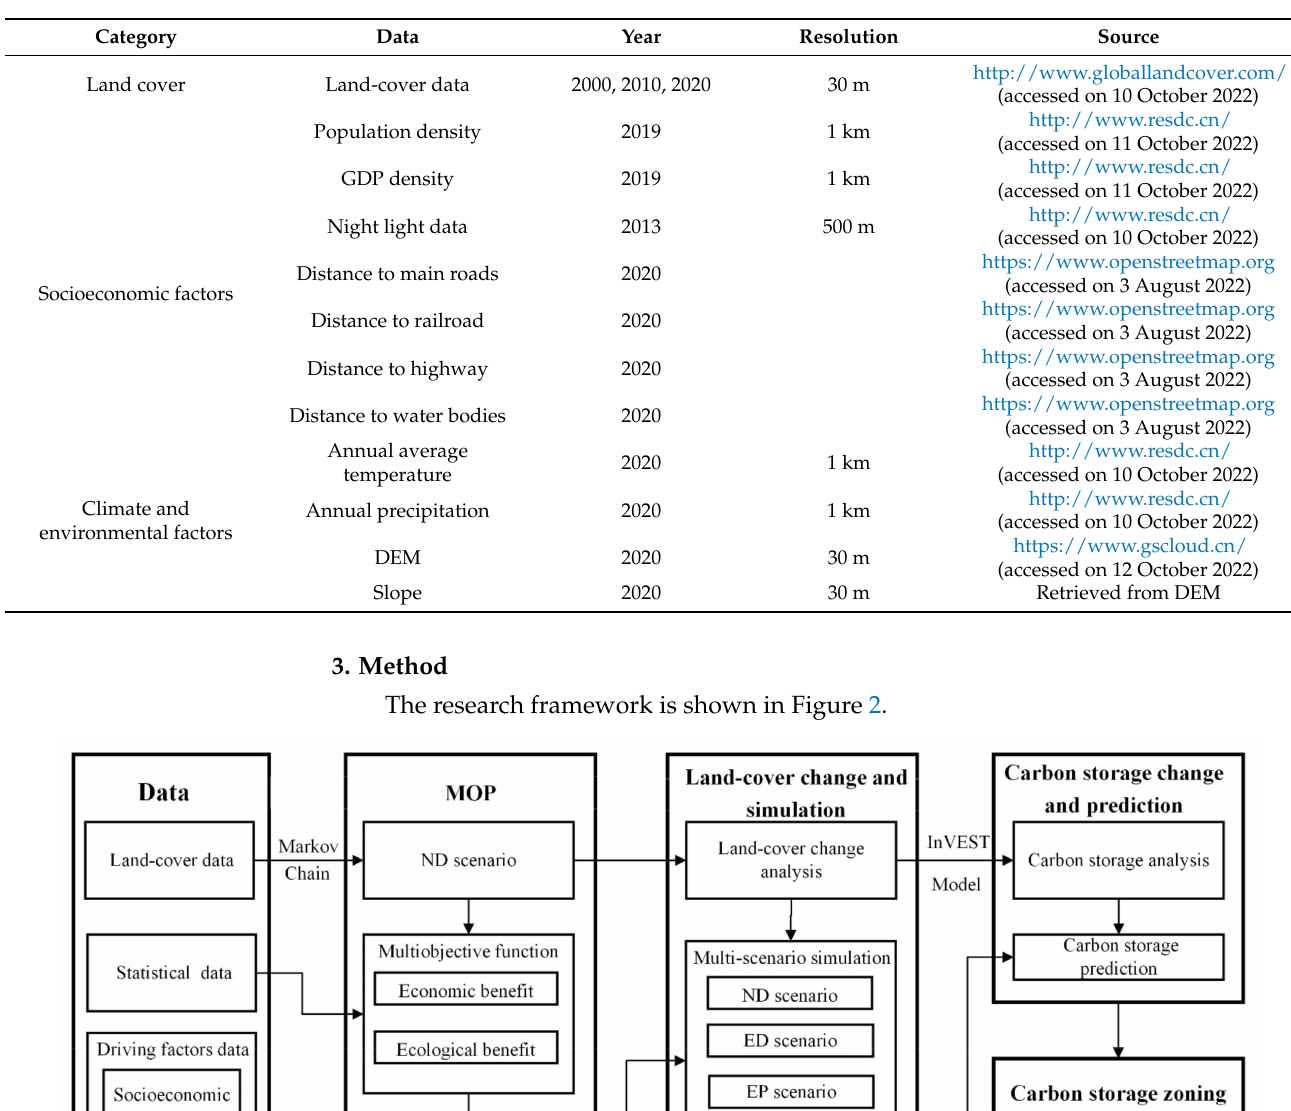
Table 1. Data information and sources.